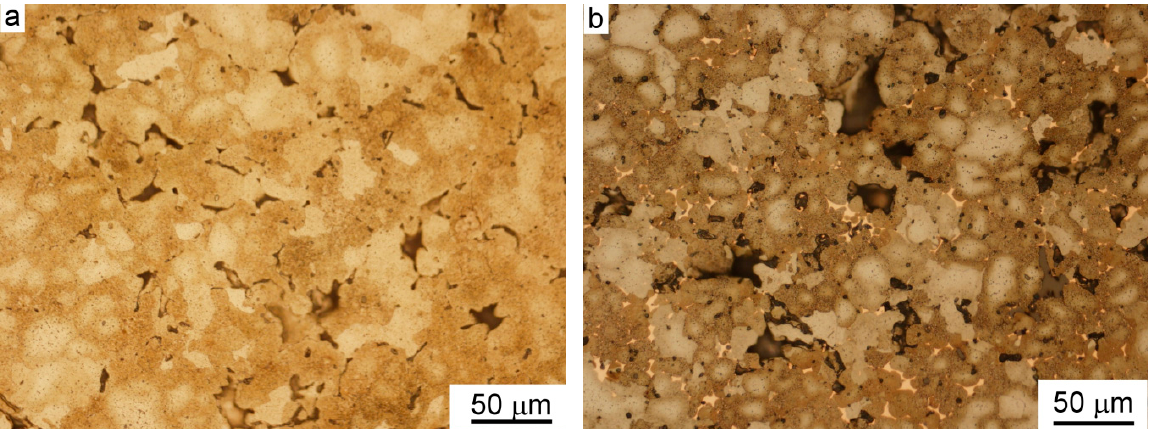
Figure 5. Microstructure of sintered materials: ( a ) Fe-3.2 wt.% Cu and ( b ) Fe-8 wt.% Cu, nital etched, LM.